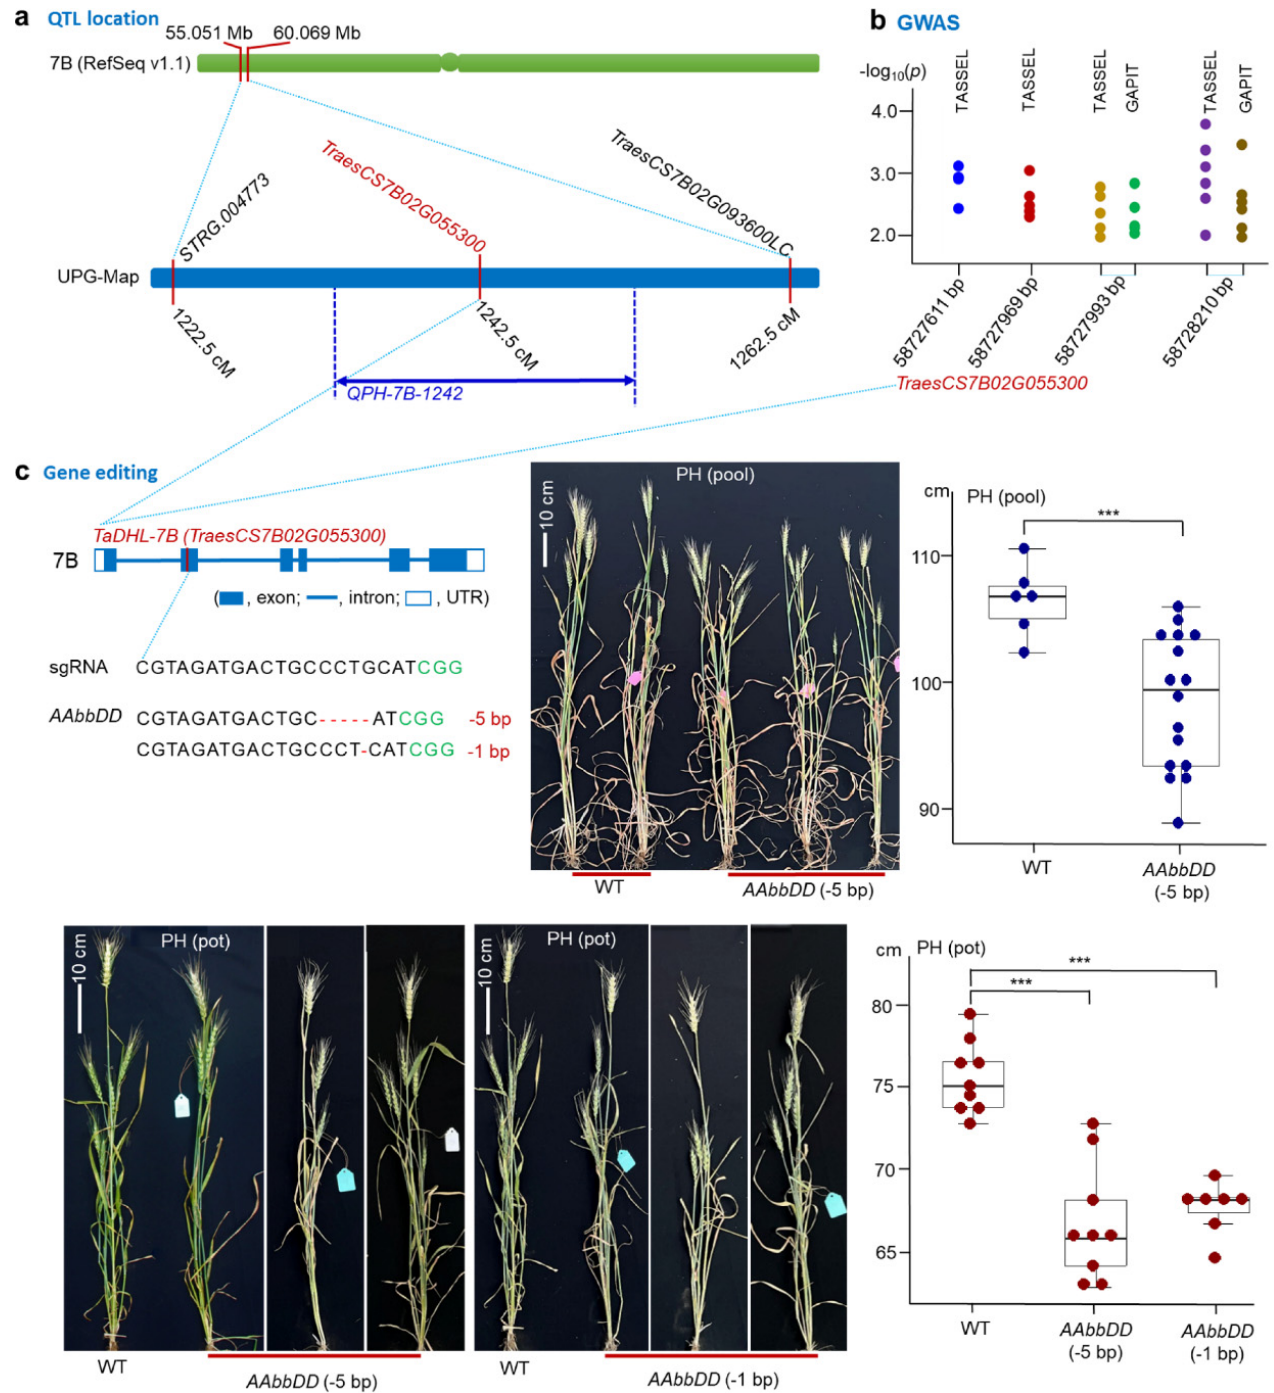
Figure 1. Physical region, QTL location, GWAS, and gene editing of TaDHL7B . ( a ) QTL location for QPh-7B-1242 determined using TL-RILs and their UPG-Map. The candidate gene TraesCS7B02G055300 was identified. ( b ) GWAS using an association population and its polymorphic SNPs/InDels. ( c ) Gene editing of TaDHL-7B using the CRISPR/Cas9 system, indicating that TaDHL-7B controls the PH. *** p < 0.001.